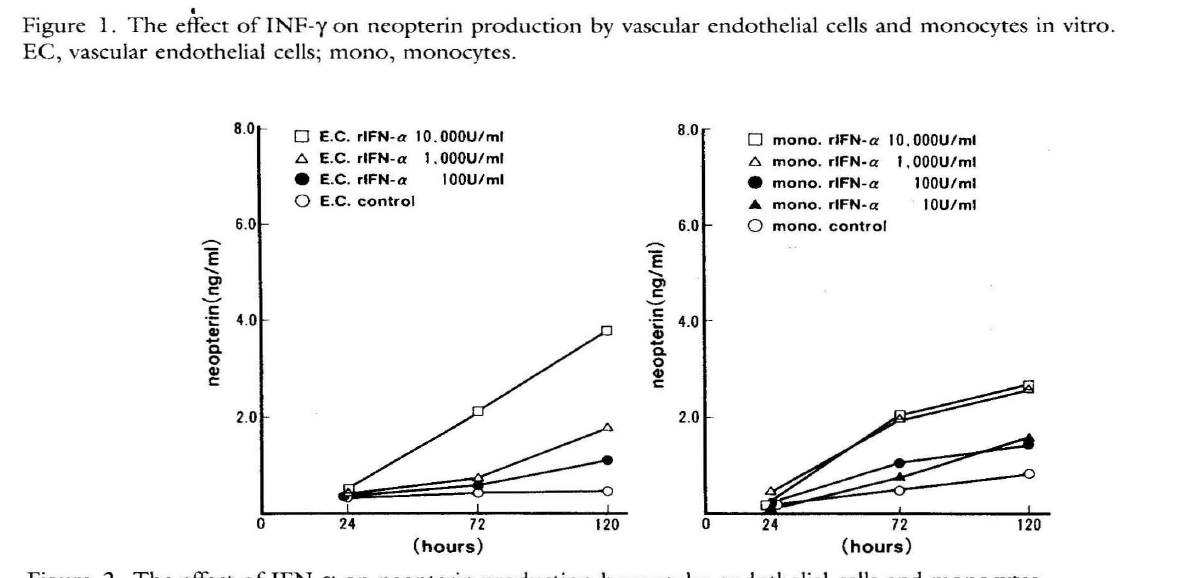
Figure 2. The effect of TFN-a on neopterin production by vascular endothelial cells and monocytes. EC, vascular endothelial cells; mono,